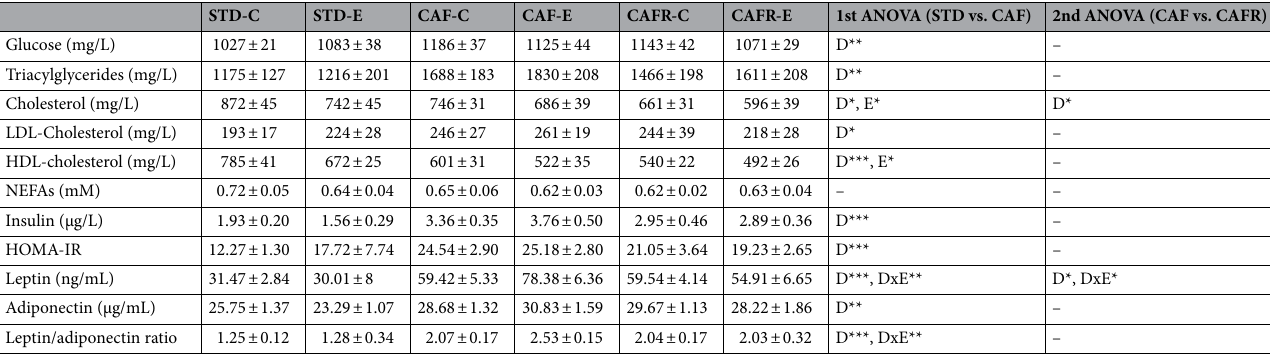
Table 2. Effects of dietary interventions and exercise on serum parameters. The two rightmost columns indicate the significant ANOVA results for analyzed factors ( D Diet; E Exercise; DxE Diet*Exercise interaction;